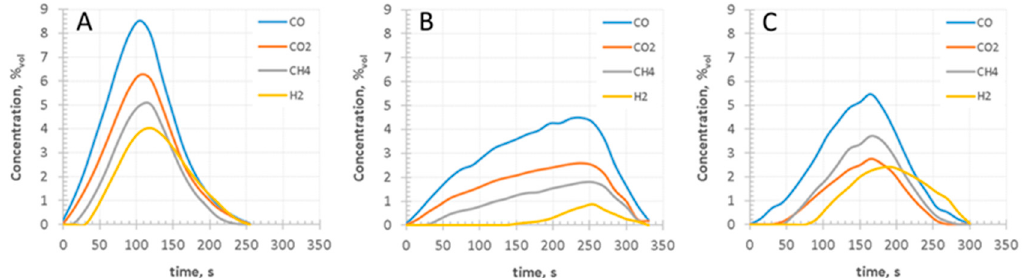
Figure 5. Concentrations of gases measured during pyrolysis experiments: ( a ) raw wood pellet; ( b ) pellet of fine wood particles torrefied at 300 °C for 5 min; ( c ) pellet of fine wood particles torrefied at 300 °C for 30 min.